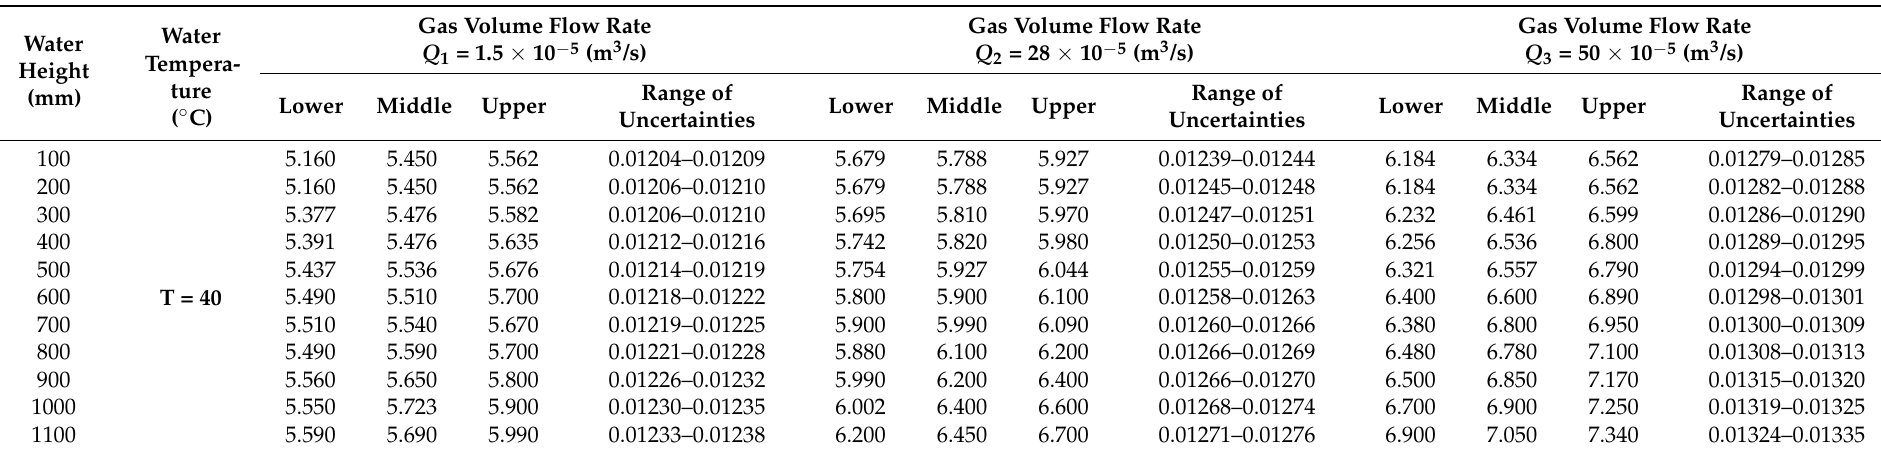
Table 4. Bubble diameter (mm) as a function of water height for T = 40 ◦ C and for gas volume flow rates Q 1 –Q 3 .